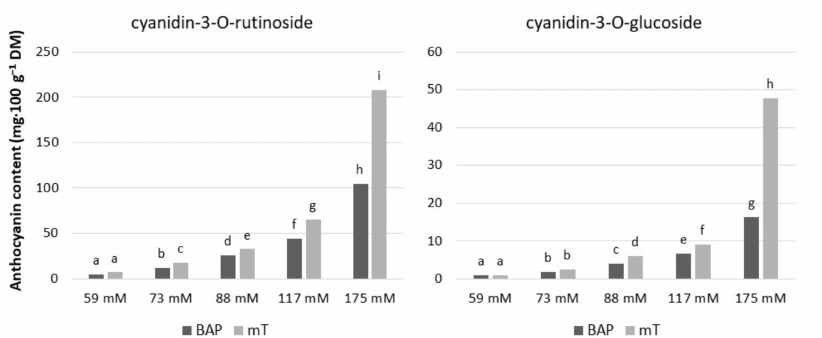
Figure 5. Contents of anthocyanin in culinary rhubarb ‘Malinowy’ after a 4-week subculture period in medium containing different cytokinin types: BAP (6.6 µ M) and mT (12.4 µ M) and sucrose levels (59, 73, 88, 117 and 175 mM). Means indicated with the same letter within cytokinin treatment do not differ significantly ( p = 0.05) according to Duncan’s